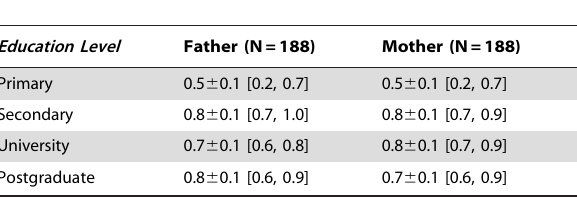
Table 5. PDRs research output in relation to their parents education: mean 6 standard error and 95% confidence interval